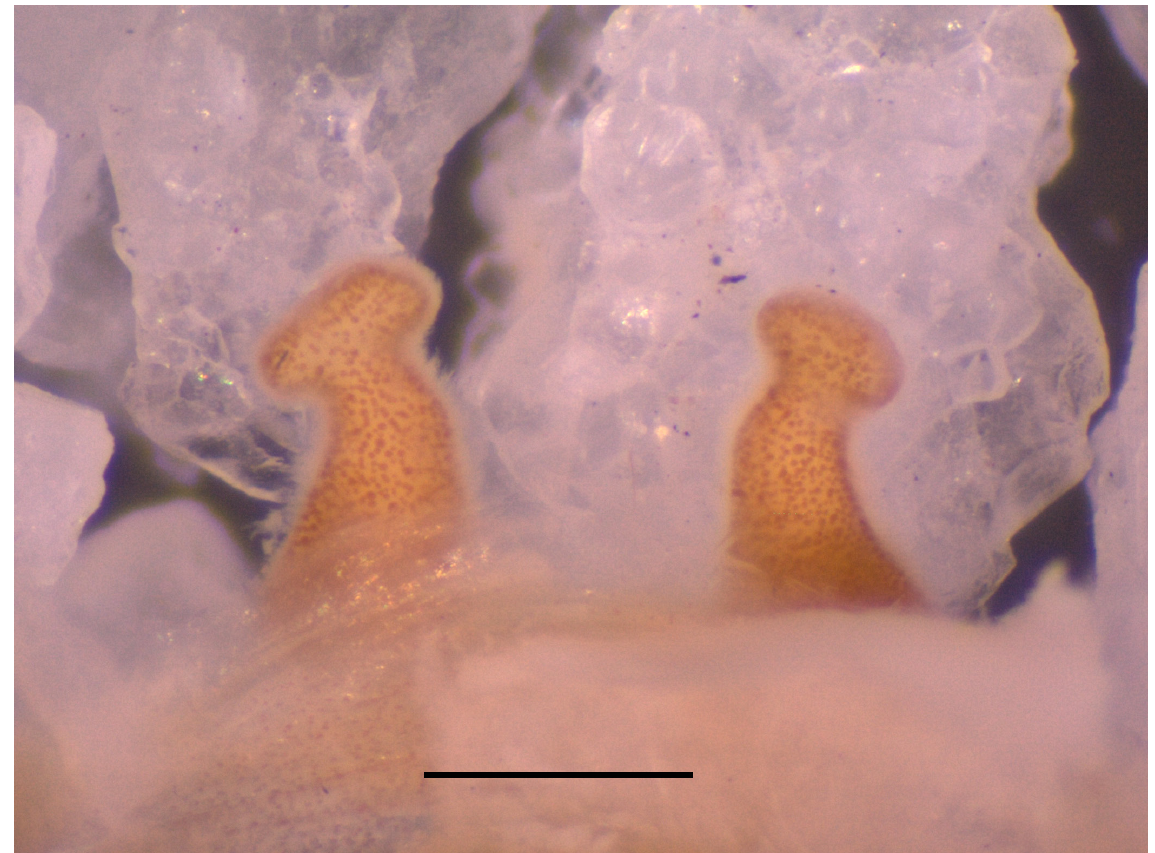
Fig. 7. Bistriopelma peyoi sp. nov., paratype, ♀ (MUBI 70); spermathecae, dorsal view. Scale bar = 1